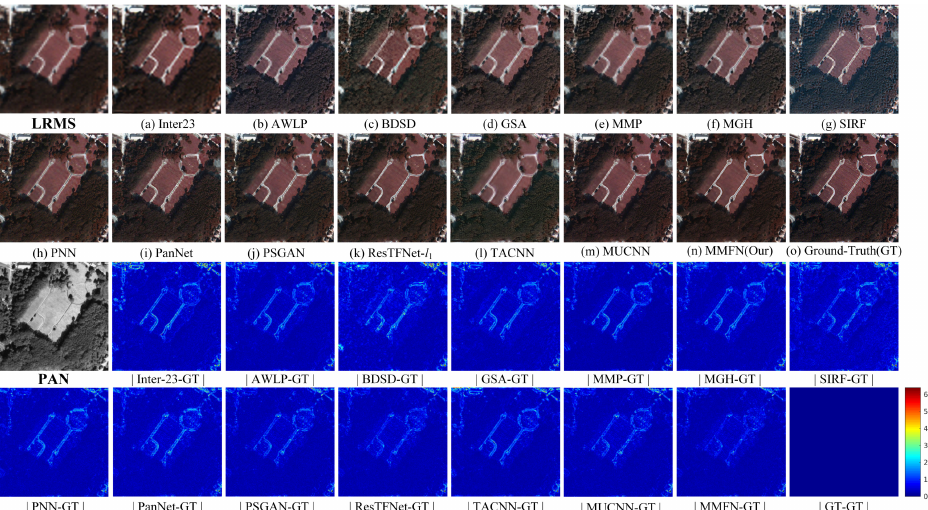
Figure 5. Qualitative comparison at reduced resolution on the WorldView-2 dataset. ( a ) Inter23, ( b ) AWLP, ( c ) BDSD, ( d ) GSA, ( e ) MMP, ( f ) MGH, ( g ) SIRF, ( h ) PNN, ( i ) PanNet, ( j ) PSGAN, ( k ) ResTFNet- l 1 , ( l ) TACNN, ( m ) MUCNN, ( n ) MMFN, ( o ) Ground-Truth (GT). The last two rows are MAEs between pansharpened results and the related ground-truth